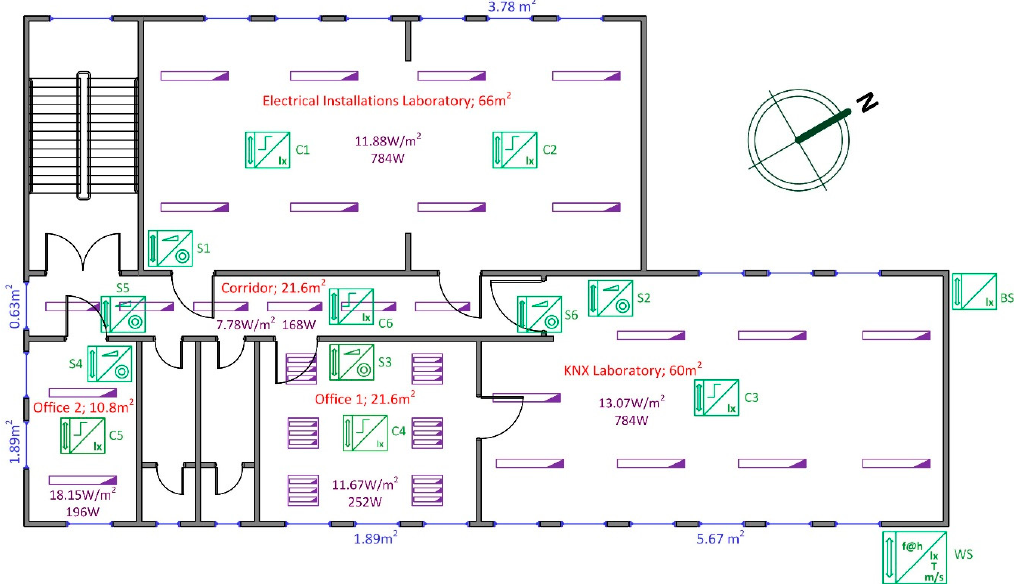
Figure 1. Layout of the SKNX & EIEE Laboratory with arrangement of lamps, installed lighting power density, and deployment of KNX BACS devices (the numbers outside the building indicate the total area of windows in the room).